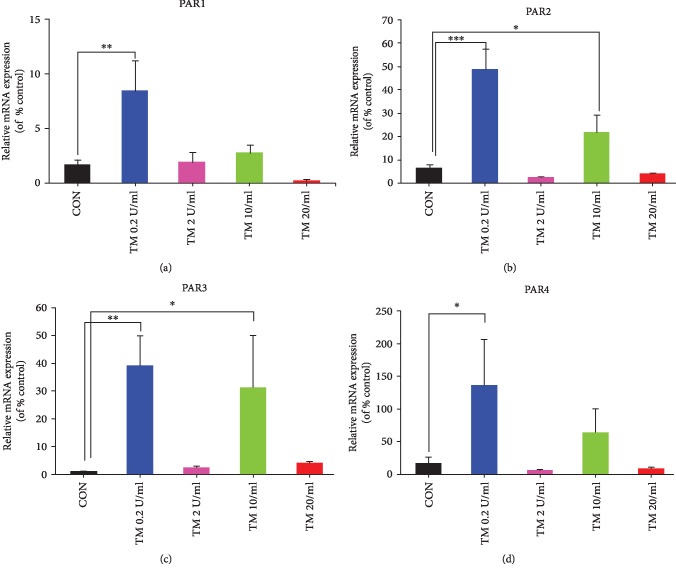
Expression of PAR1, PAR2, PAR3, and PAR4 in P815 cells after 16 h stimulation with the diverse concentration of thrombin. P815 cells were stimulated by various concentrations of thrombin at 37°C for 16 h. The expression of PAR1 (a), PAR2 (b), PAR3 (c), and PAR4 (d) mRNA in P815 cells was determined by qRT-PCR. Each trial was repeated three times. ANOVA was performed. Multiple comparisons were applied to compare the difference among the four groups. ∗ indicates that the difference between the control group and the diverse concentration of thrombin was statistically significant (∗P < 0.05; ∗∗P < 0.01; ∗∗∗P < 0.001). CON: control groups. P815 cells were incubated with an equal volume vehicle. GAPDH expression was the folding control.